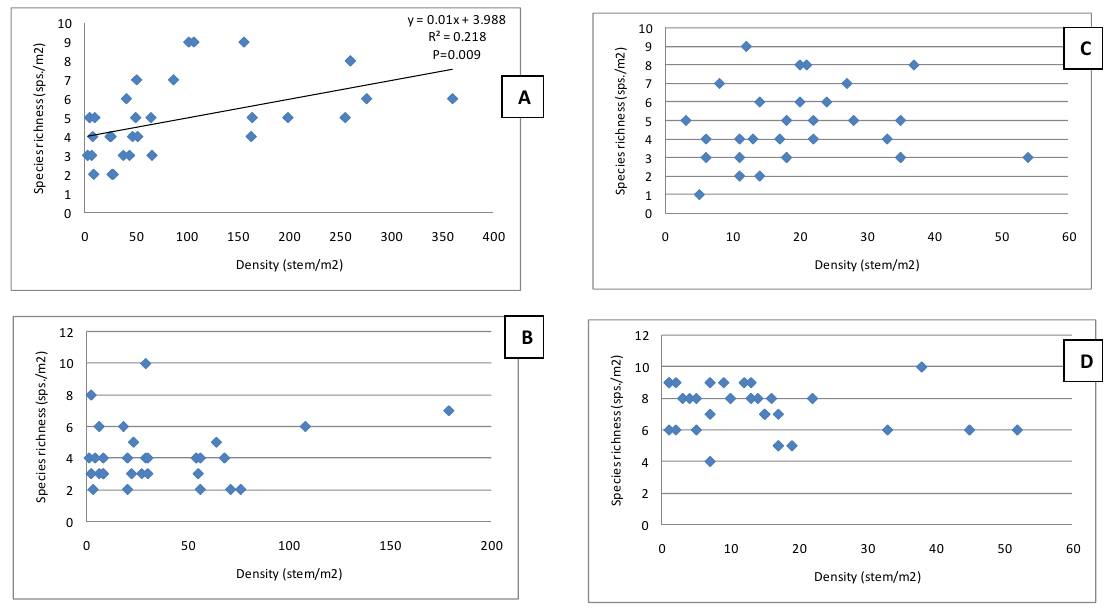
Fig. 7: Variation of flowering plant species richness with the density of Parthenium weed in different lands-use types: A) waste land, B) road side, C) tree plantation and D) abandoned agriculture land. Regression line was fitted when the relation was significant Titepati ( Artemisia indica ) because it looks similar to Parthenium in vegetative stage. About 63% of the respondents noticed the presence of Parthenium for 8-9 years in their area, but 20% respondent said that they observed this weed for 4-5 years. Most of the respondents (65%) noticed that Parthenium first appeared in road side. About 83% did not notice